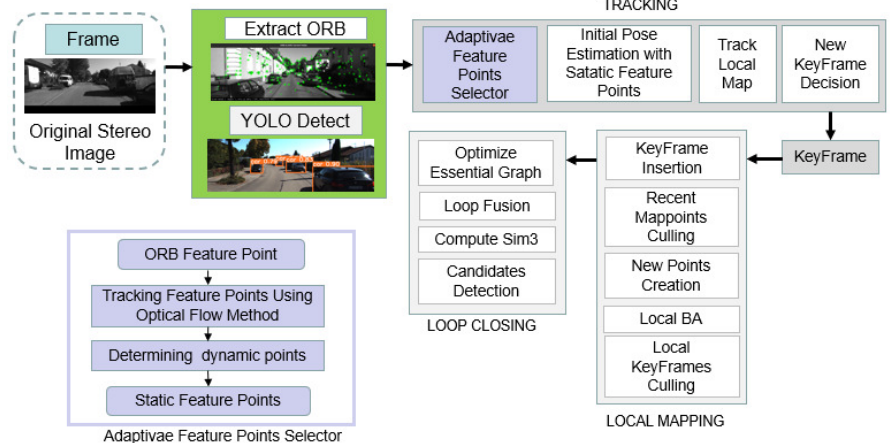
Figure 1. The system framework for the proposed